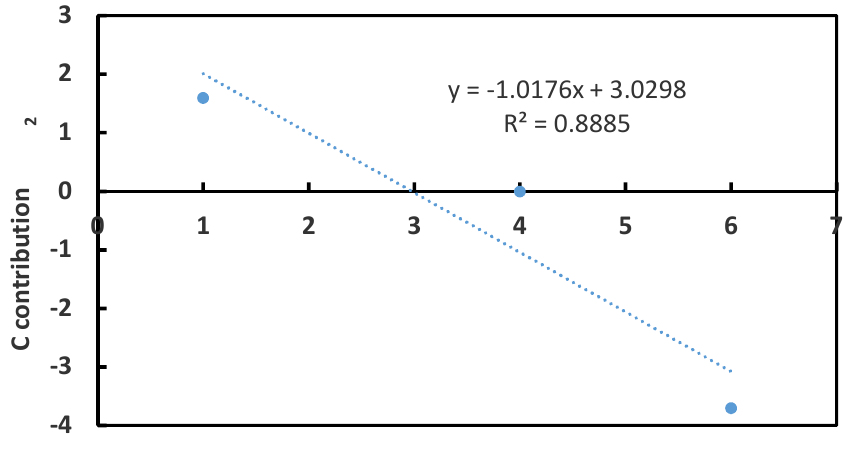
Figure 8. Ethoxy contribution ξ 2 versus the number of Ethoxy (C 2 H 4 O) groups in the molecule.